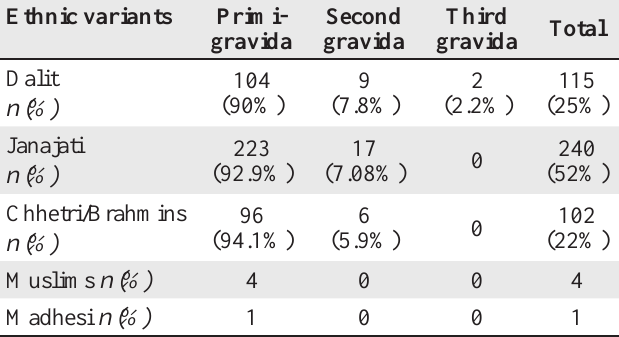
Table 2 . Distribution of ethnical variants according to gravidity